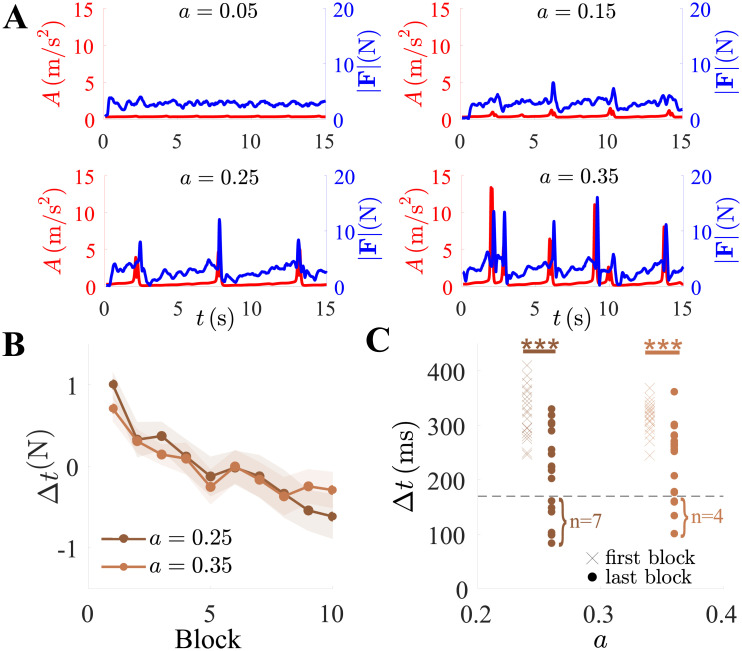
Anticipation of the transient target occurred with practice.(A) The chaotic target’s acceleration magnitude A (red) and the force magnitude |F| (blue) as a function of time from four sample trials with increasing control parameter a from top-left to bottom-right. (B) Normalized movement delay Δt(N) as a function of the block number. (C) Δt in the first and last blocks as a function of control parameter a for each individual participant. With practice, the participants reduced their movement delay in response to the fold. *** represents p < 0.001.